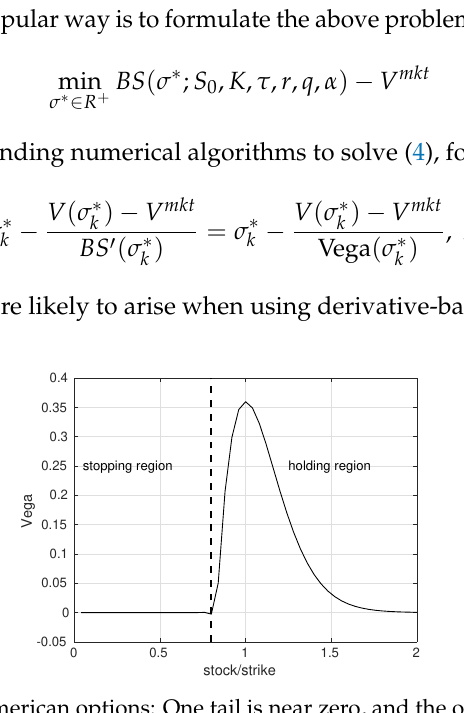
Figure 1. The Vega for American options: One tail is near zero, and the other tail is flat (zero